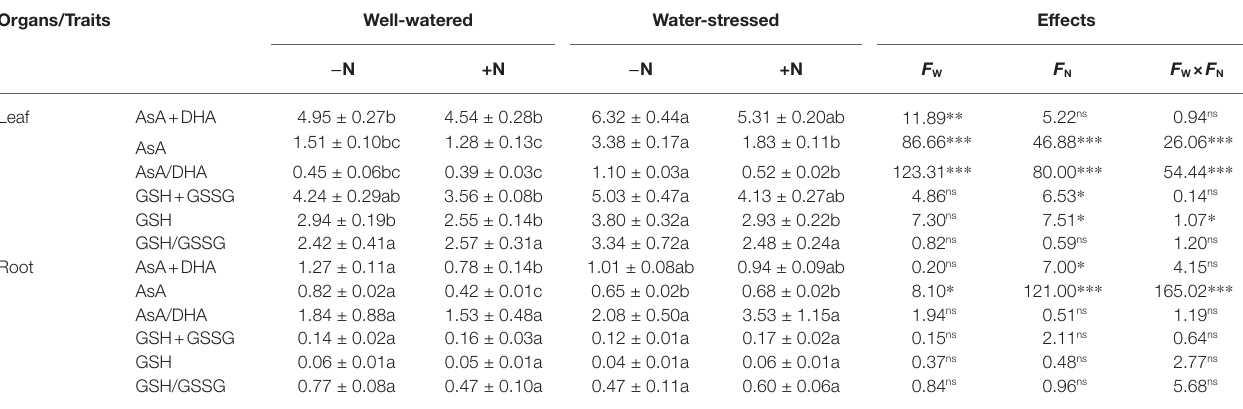
TABLE 3 | Antioxidants contents of Fargesia denudata leaves and roots for N non-deposition ( − N) and N deposition (+N) treatments with and without drought stress. Organs/Traits